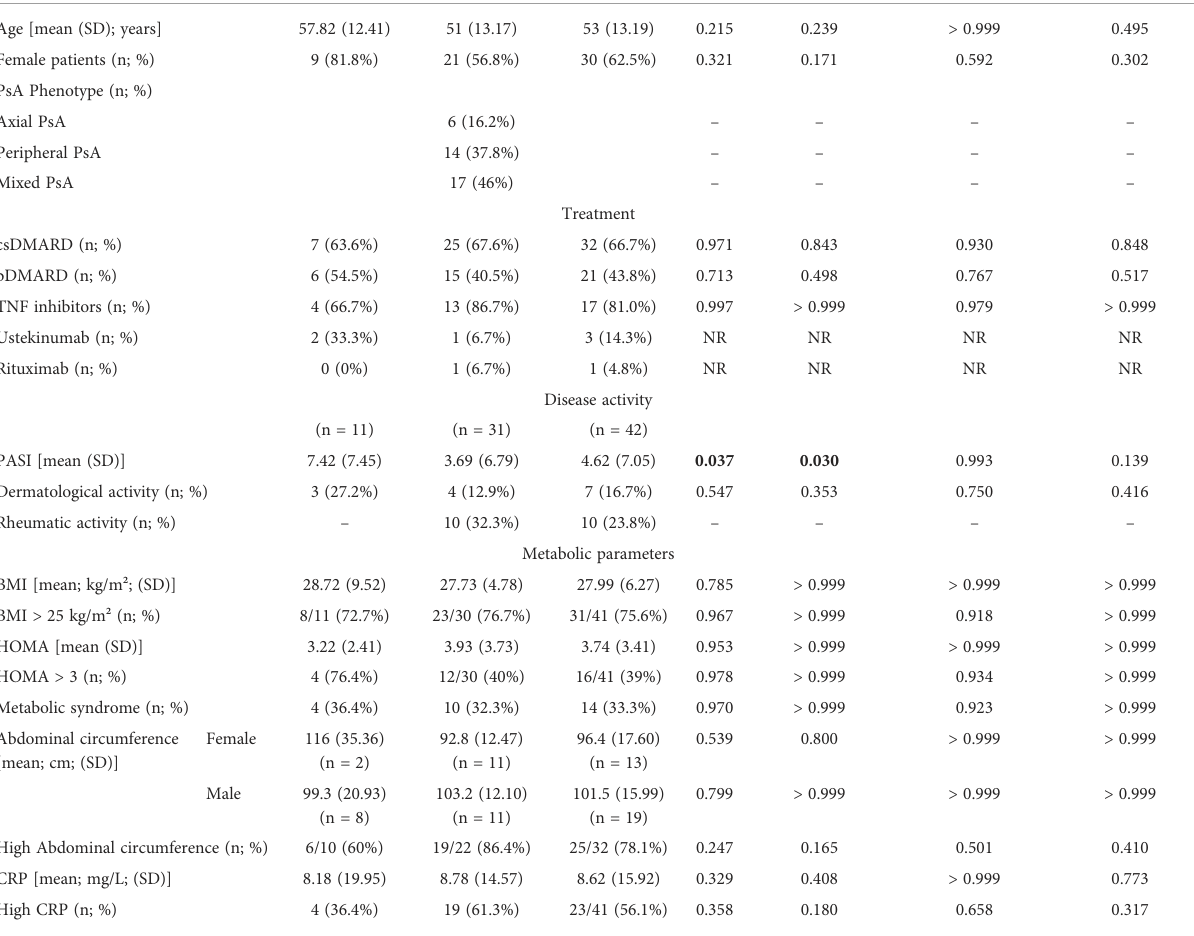
TABLE 1 Description of the